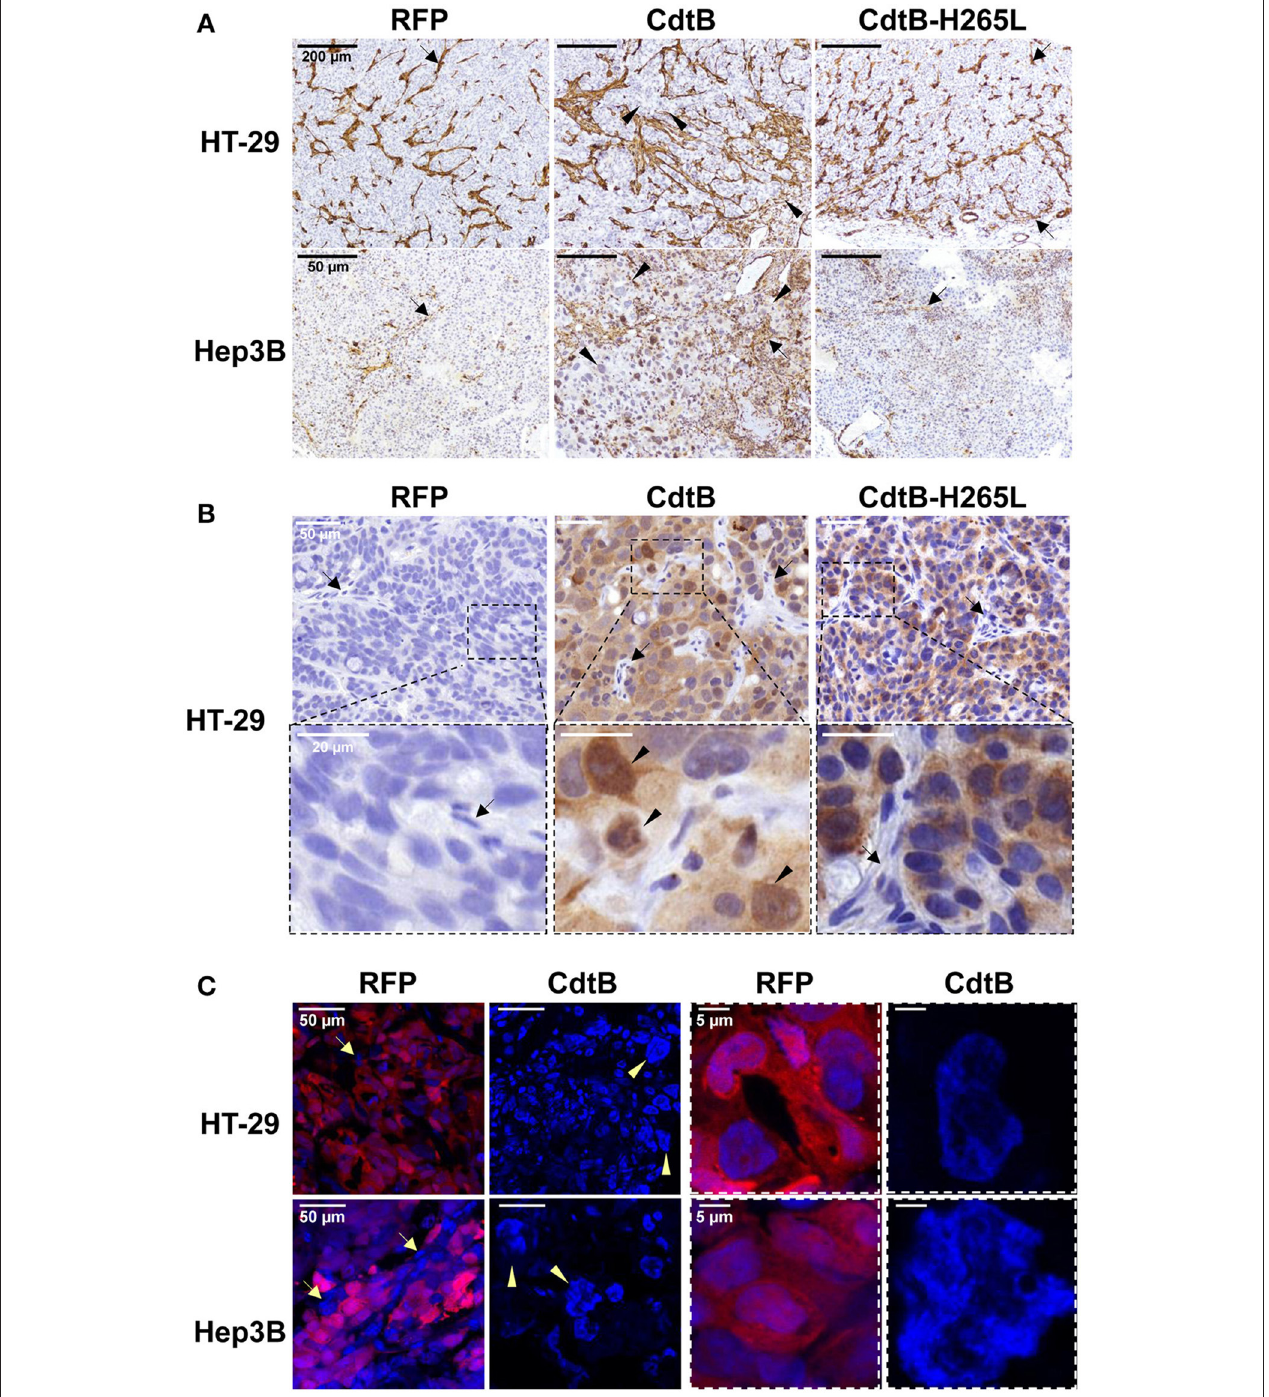
FIGURE 3 | Detection and effects of Helicobacter hepaticus CdtB expression in tumor xenografts. Three µ m-tissue sections of HT-29- and Hep3B-derived tumors were prepared from formalin-fixed paraffin-embedded tissues and submitted to standard hematoxylin staining and immunostaining raised against alpha smooth muscle actin (A) and HA (B) to detect murine infiltrates and the HA-tagged proteins (CdtB and CdtB H265L in HT-29-derived tumors), respectively. Boxes in (B) correspond to enlargement. (C) RFP fluorescence was visualized in 5 µ m-tissue sections of HT-29- and Hep3B-derived tumors prepared from OCT-embedded tissues using a confocal microscope. Nuclei were counterstained with 4 ′ ,6-diamidino 2-phenylindole (DAPI) (blue). Boxes correspond to enlargement of cells and nuclei for RFP-derived tumors and to giant nuclei for CdtB-derived tumors. Tips of arrows indicate distended nuclei as compared to the RFP control or CdtB-H265L tumors. Arrows point to murine cell infiltrates. CdtB, CdtB of H. hepaticus strain 3B1; CdtB-H265L, H. hepaticus CdtB with H265L mutation; RFP, red fluorescent protein.